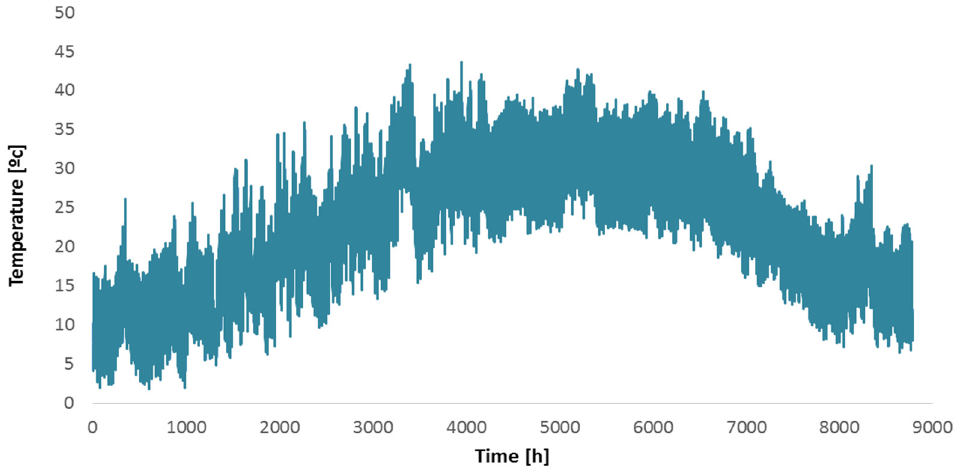
Figure 3. T he annual short-wave solar irradiance of the studied area. Figure 3. The annual short-wave solar irradiance of the studied area.